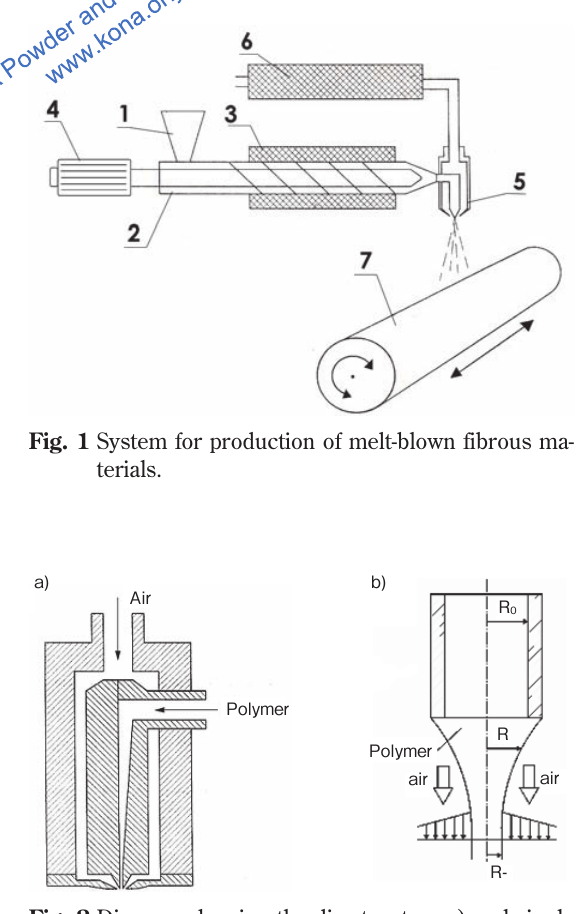
Fig. 2 Diagram showing the die structure a) and single fiber formation